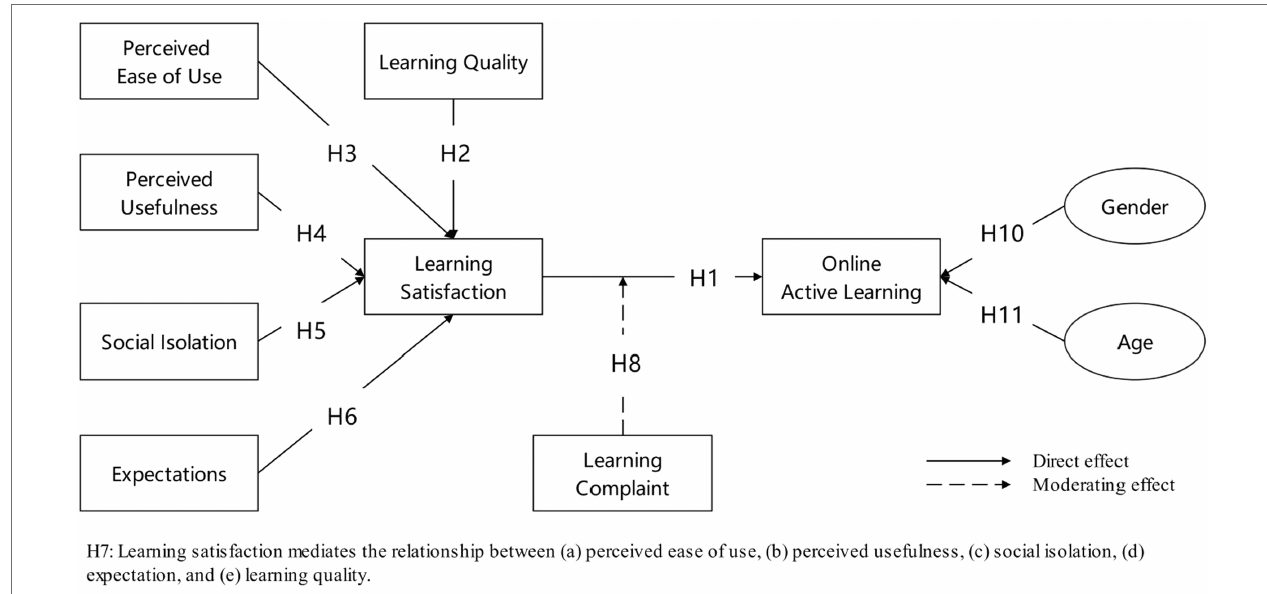
FIGURE 1 | Conceptual